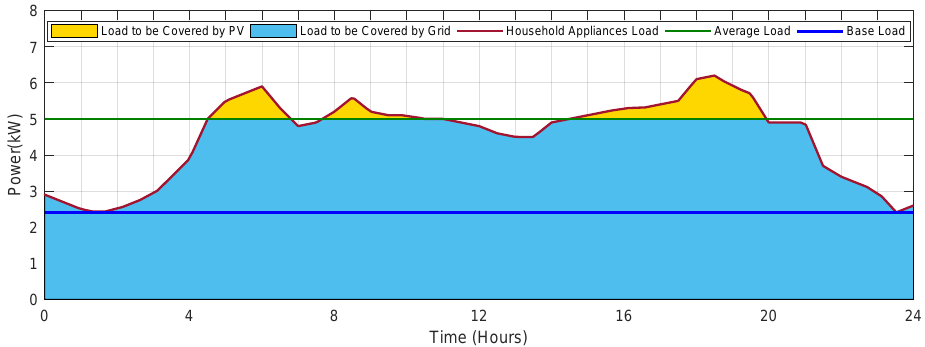
Figure 2. Hourly household appliances electricity